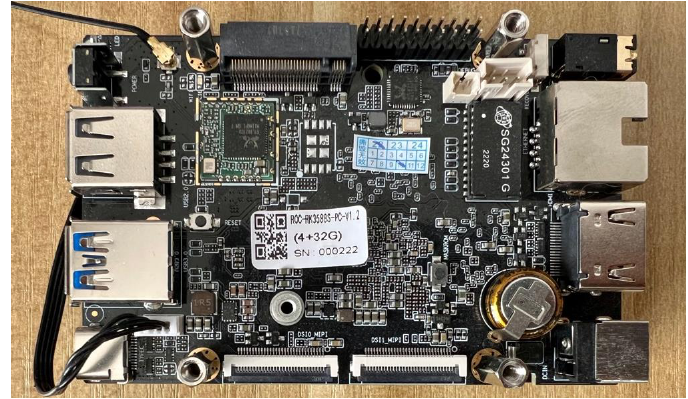
Figure 9. The RK3588 embedded development board.